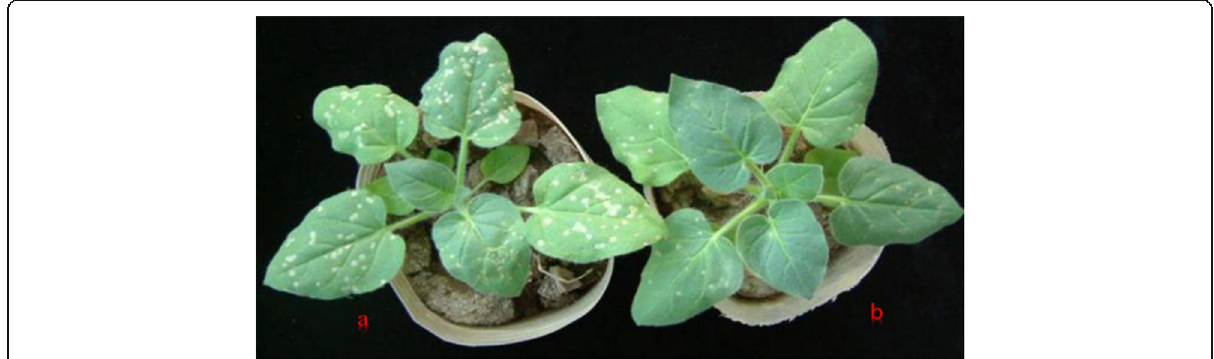
Fig. 3 Control effect of the AgNPs on Nicotiana glutinosa , ( a ) represented the control. Inoculated only with TMV broth, while ( b ) treated with AgNPs and inoculated with TMV. Control showed maximum lesion but the treated plant showed maximum reduction of TMV